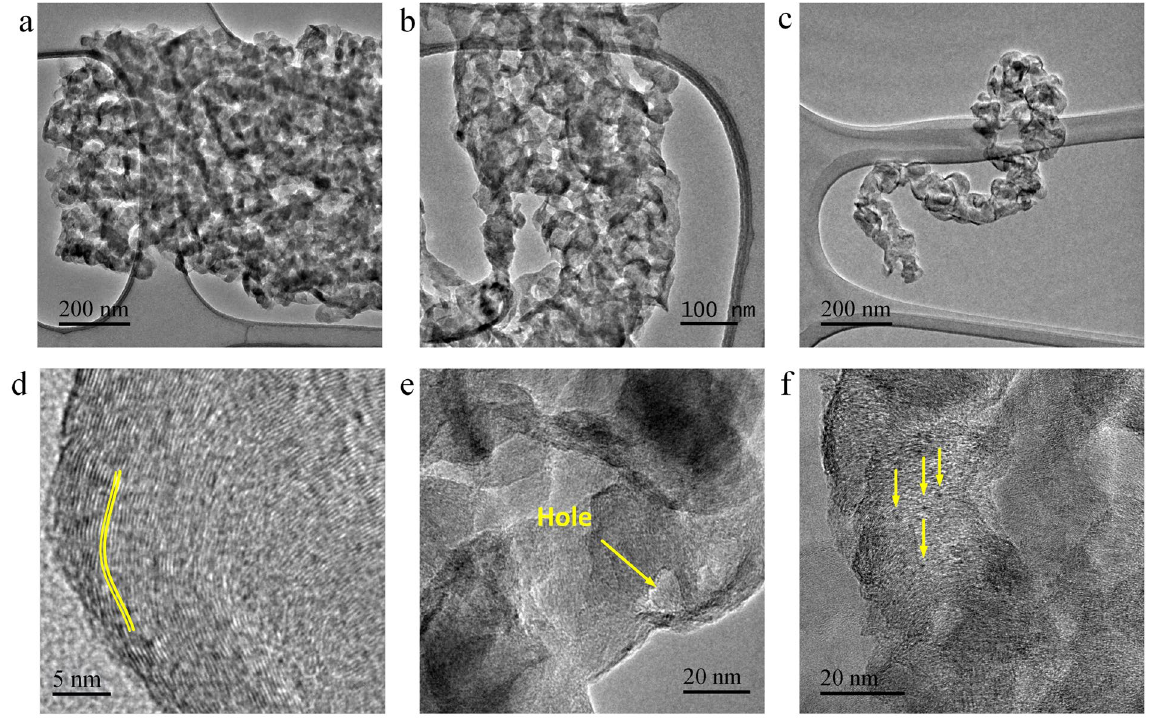
Figure 2. TEM and HRTEM images of N-CB structures. ( a,b ) Top views of N-CBs. The arrows in ( b ) indicate the wrinkled carbon fibres. ( c ) High magnification image of a wrinkled carbon fibre. ( d–f ) HRTEM images of wrinkled carbon fibres. ( d ) Curved graphite layers with an interlayer distance of ~3.5 Å, ( e ) Holed wrinkled carbon fibres, and ( f ) Cu-nanoparticles of ~2 nm diameter anchored on the surface of wrinkled carbon